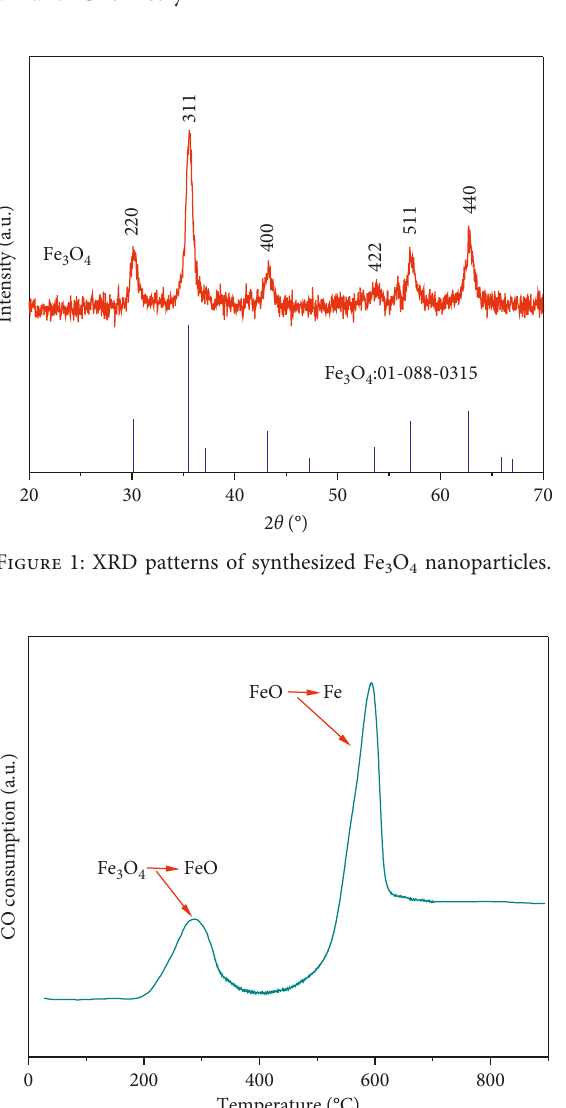
Figure 2: TPR CO profile for Fe 3 O 4 nanoparticles, a heating rate of 5 °